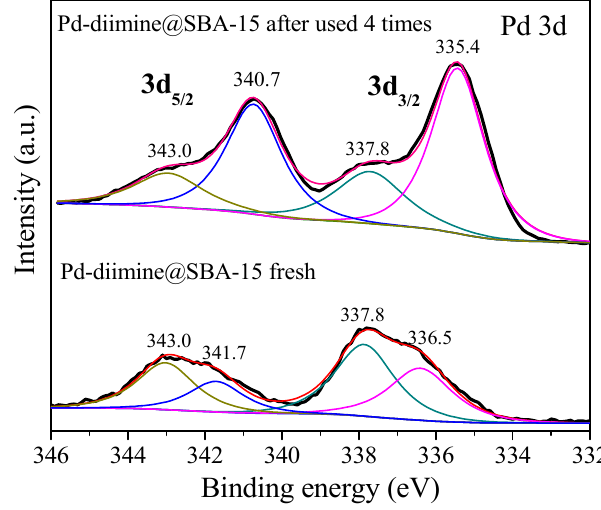
Figure 3. X ‐ ray photoelectron spectroscopy (XPS) spectra of Pd ‐ diimine@SBA ‐ 15 (fresh and after Figure 3. X-ray photoelectron spectroscopy (XPS) spectra of Pd-diimine@SBA-15 (fresh and after being being used four times). used four